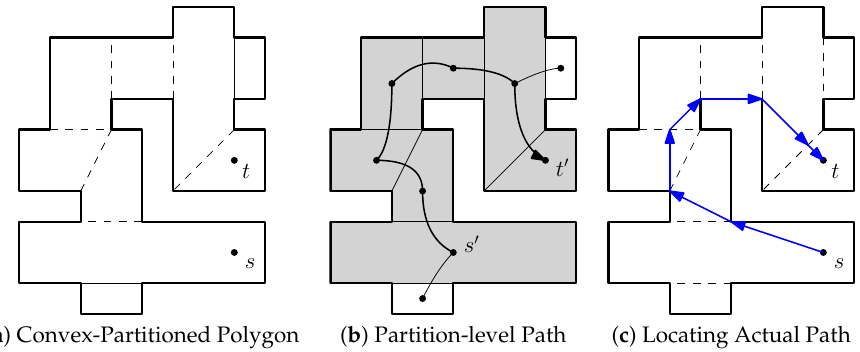
Figure 12. Illustration of the path-finding